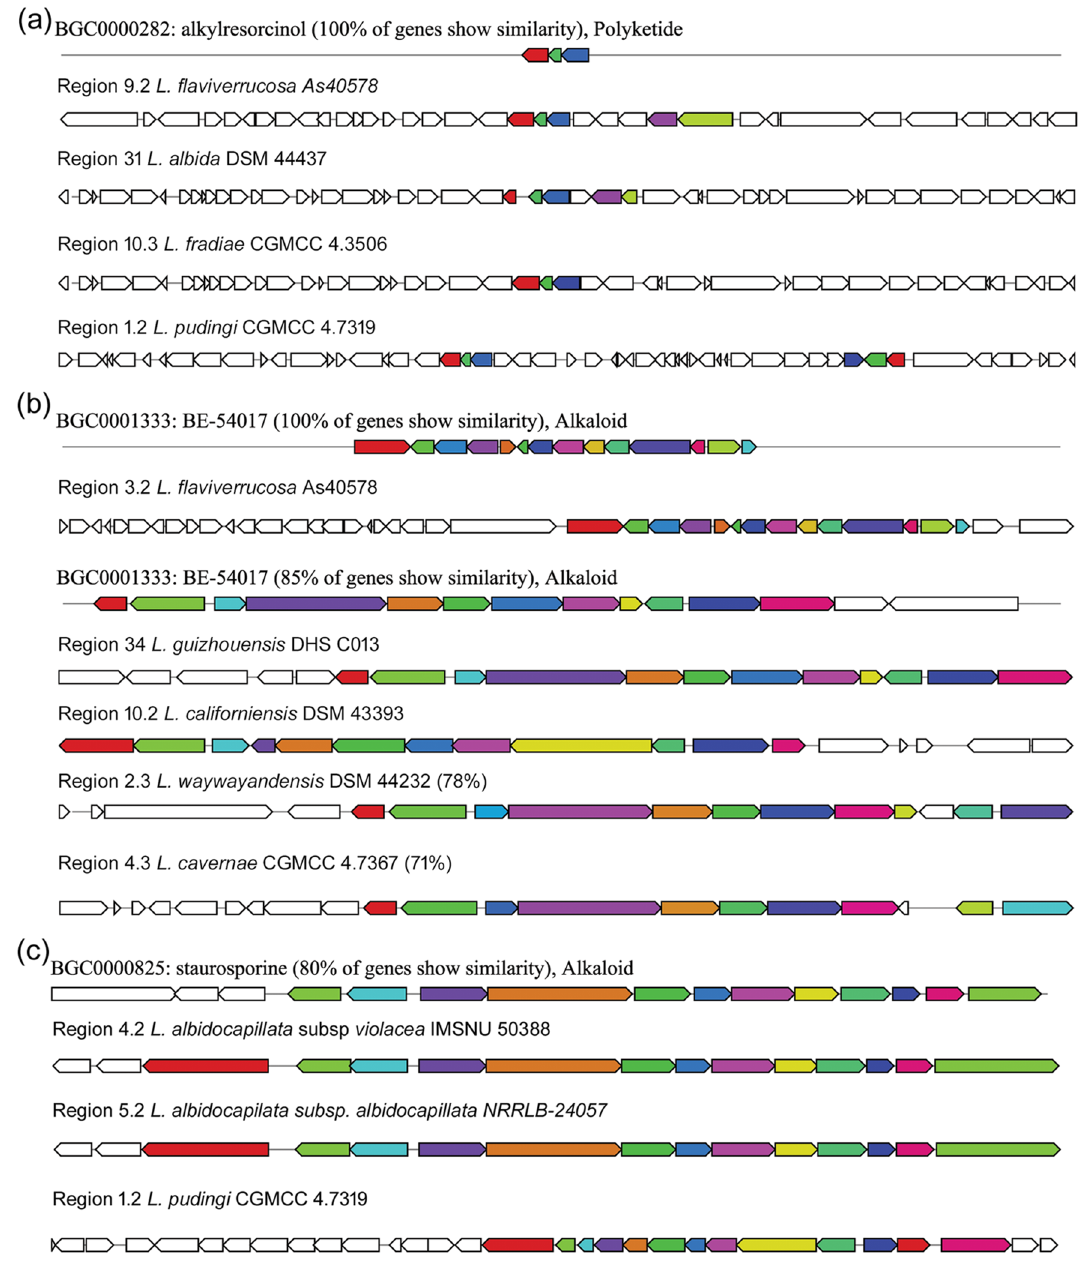
Figure 8. Highly similar antitumor gene clusters of Lentzea species compared with known clusters in the antiSMASH database. ( a ) alkylresorcinol, ( b ) BE-54017, ( c )